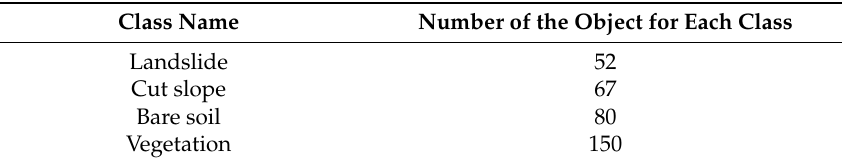
Table 1. Number of selected training objects in four